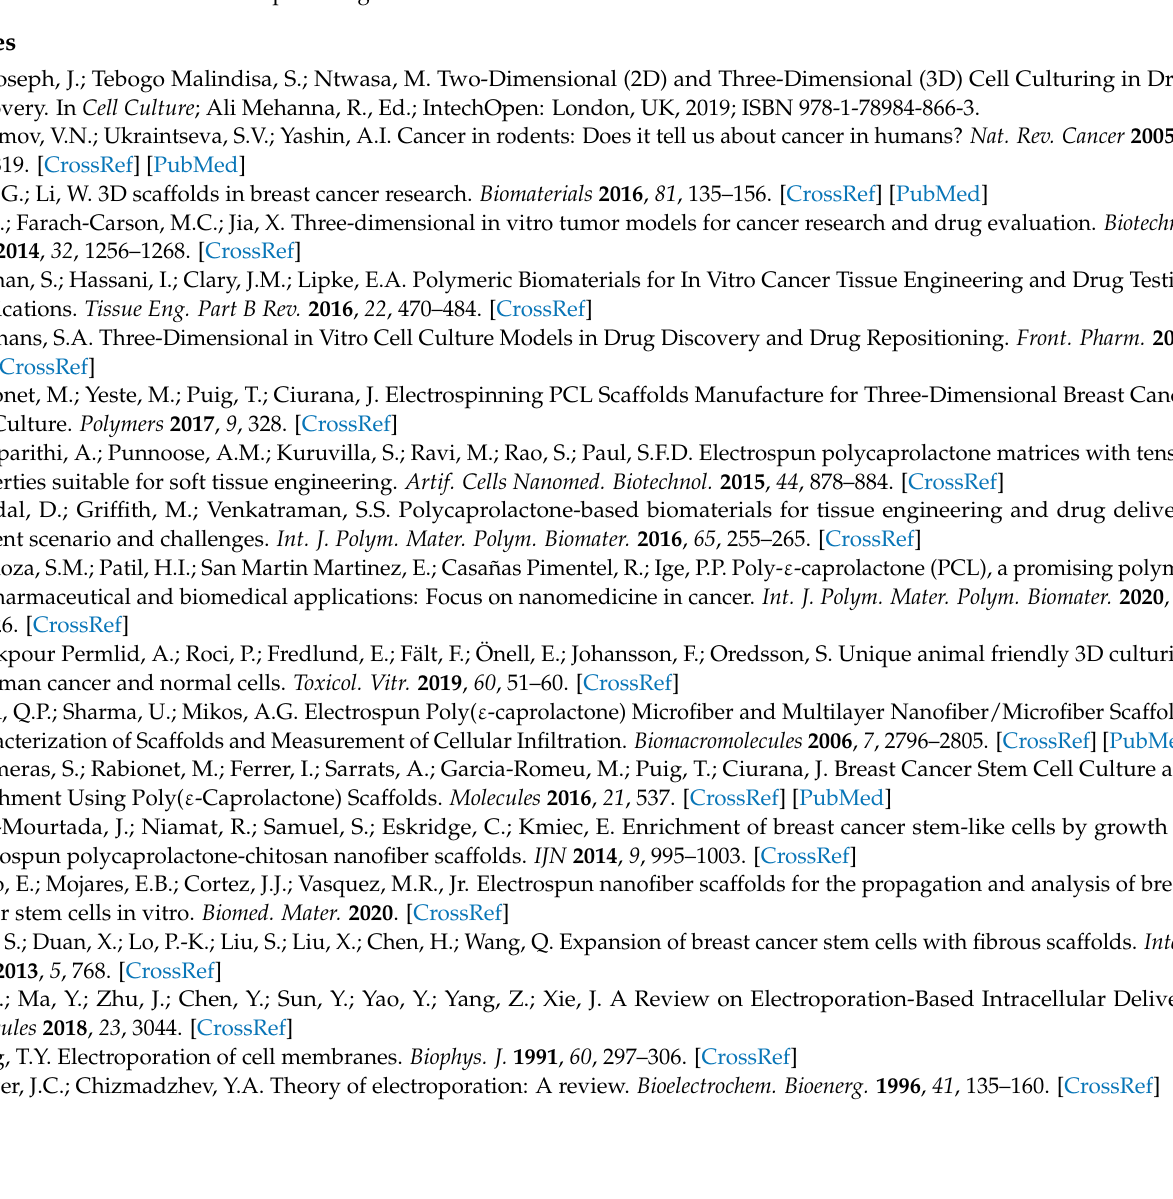
Figure A1. ( a ) Masson’s trichrome staining of cultures grown on PCL at 7 days from seeding. Image on the left shows PCL scaffold without cells, whereas image on the right reports PCL-based cultures. Collagen stains: blue, cytoplasm: red, and nuclei: black. Bars: 100 µm. ( b ) RT-PCR analysis of Col1a1 of cultures grown on tissue-culture polystyrene (TCP), and PCL scaffolds at 7 days from seeding. Quantification of transcript levels was carried out by densitometric analysis using ImageLab software. Data were reported as a percentage from TCP taken as 100. Student’s t test.